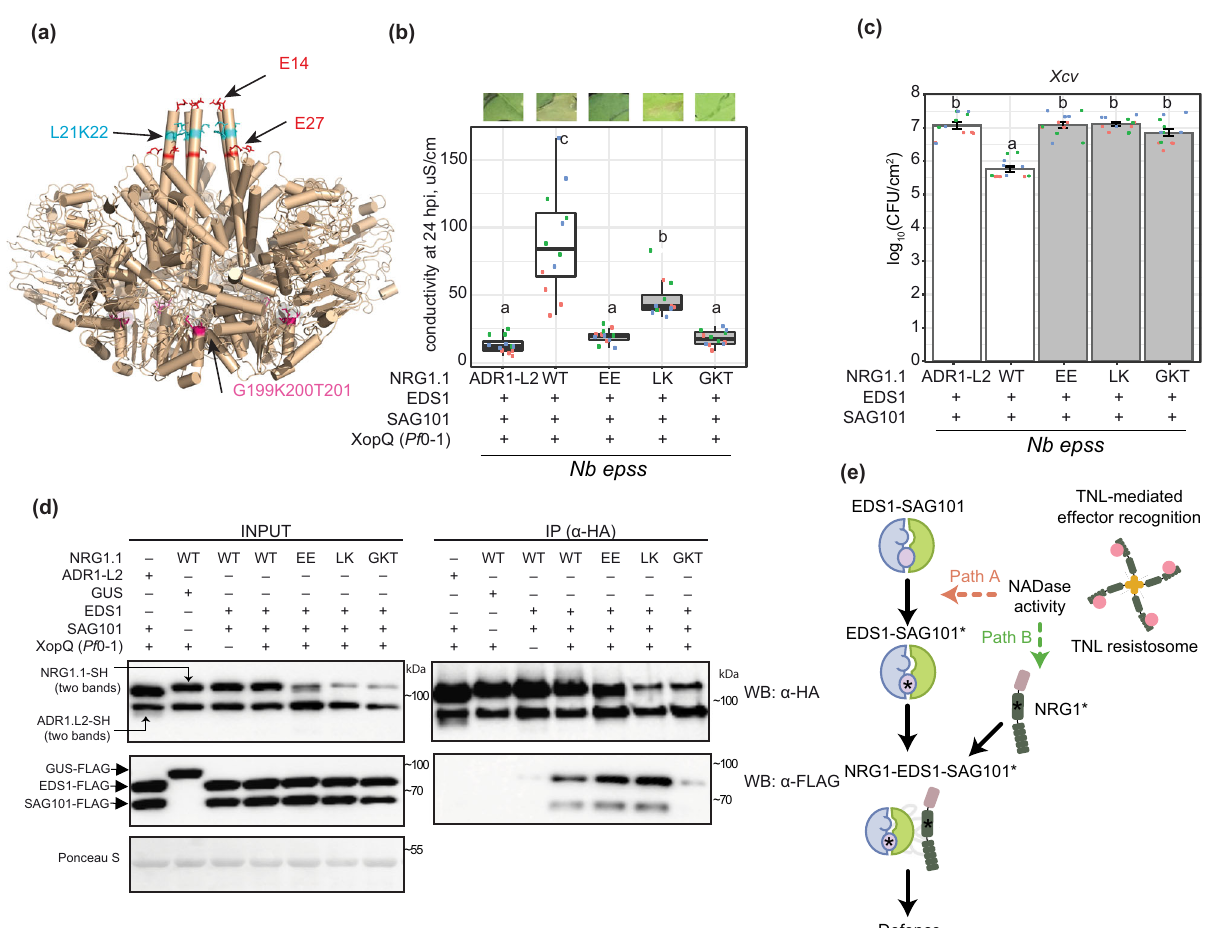
Fig. 6 Association between Arabidopsis NRG1.1, EDS1 and SAG101 require an intact NRG1.1 P-loop. a A structure homology model of Arabidopsis NRG1.1 based on the ZAR1 resistosome. NRG1.1 amino acids E14 and E27 (red sticks) and L21 and K22 (blue sticks) aligned with residues E11, E18, F9, L10 and L14 in ZAR1. The modelled NRG1.1 P-loop motif (G199 K200 T201) is shown as cyan sticks. XopQ-triggered cell death ( b ) and Xanthomonas campestris pv. vesicatoria strain 85-10 ( Xcv ) growth restriction ( c ) in Nicotiana benthamiana eds1a pad4 sag101a sag101b ( Nb epss ) expressing Arabidopsis NRG1.1-SH wildtype, NRG1.1 E14A/E27A , NRG1.1 L21A/K22A and NRG1.1 G199A/K200A/T201A variants together with EDS1-FLAG and SAG101-FLAG. Arabidopsis proteins were expressed via Agrobacteria -mediated transient expression assays two days before in fi ltration of Pseudomonas fl uorescens 0-1 ( Pf 0-1) XopQ (OD 600 = 0.3) or simultaneously with Xcv (OD 600 = 0.0005). Experiments were performed three times independently, each with four replicates (leaf discs) (Tukey ’ s HSD, α = 0.001, n = 12). Error bars represent standard error of mean. Datapoints with the same colour come from one independent experiment. d Immunoprecipitation (IP) and Western blot (WB) analyses testing associations of Arabidopsis NRG1.1 mutant variants with EDS1 and SAG101 in Nb epss after triggering Roq1 signalling by Pf 0-1 XopQ in fi ltration (OD 600 = 0.3; 10 hpi). Arabidopsis EDS1-FLAG, SAG101-FLAG with NRG1.1-SH, and using GUS-FLAG and Arabidopsis ADR1-L2-SH as negative controls, were expressed using Agrobacteria 2 d prior to Pf 0-1 XopQ in fi ltration. After α -HA IP, the indicated fractions were analysed with α -HA and α -FLAG antibodies by WB. The experiment was conducted three times independently with similar results. e Model of molecular events leading to generation of an Arabidopsis EDS1 – SAG101 – NRG1 signalling complex essential for TNL receptor-activated defence. NRG1 – EDS1 – SAG101 association is dependent on TNL activation and requires an intact EDS1 – SAG101 heterodimer EP domain cavity (purple circle) and NRG1 nucleotide-binding domain. In two depicted scenarios, an effector-induced TNL oligomer with NADase activity leads to activation (asterisks) of EDS1 – SAG101 via the EP domain cavity ( ‘ Path A ’ , asterisk inside the purple circle) or NRG1 ( ‘ Path B ’ ). These paths are not mutually exclusive. EDS1 – SAG101 – NRG1 assembly precedes and is necessary for TNL-triggered cell death and resistance involving a predicted NRG1 N-terminal HeLo domain α